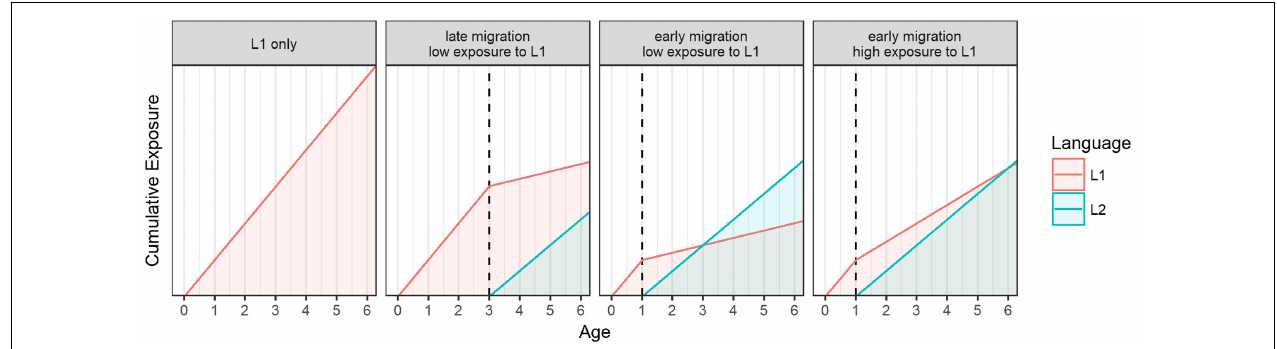
FIGURE 1 | Four examples of how cumulative exposure to L1 and to L2 may change with age. The intensity of exposure corresponds to the line slopes, whereas the position on the Y-axis corresponds to cumulative exposure. The examples vary with respect to the age of migration (age of contact with L2, indicated by the dashed line) and the subsequent intensity of exposure to